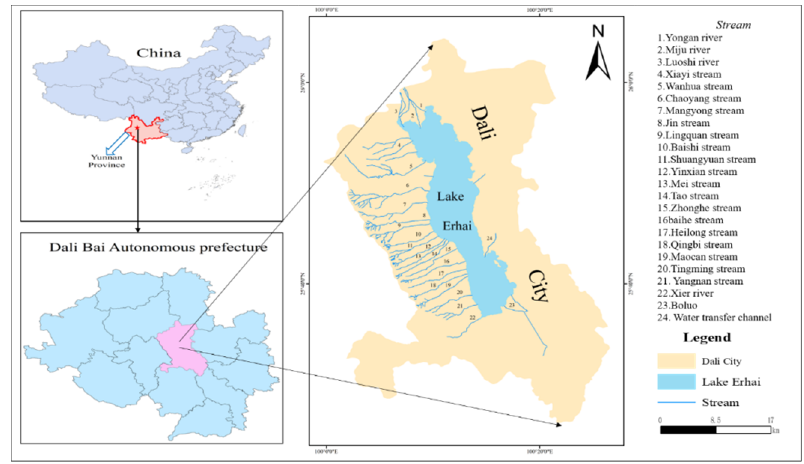
Figure 1. Distribution diagram of the study area of Erhai Lake. The map shows the location of Erhai Lake and Erhai Basin in China, and the distribution of the major inflow and outflow sources of Erhai Lake.